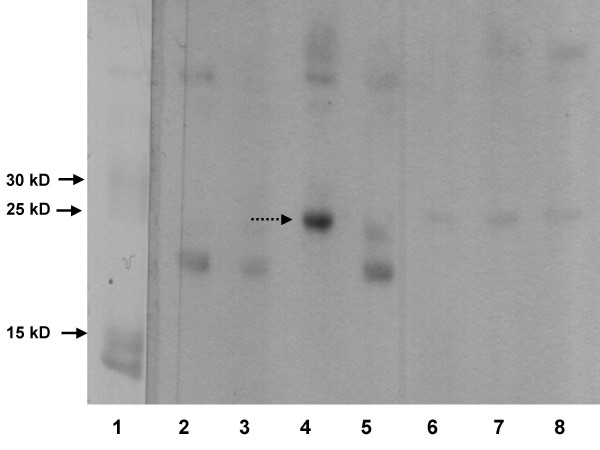
Western blot analysis for PIF after urinary protein extraction. Lane 1: Rainbow® recombinant protein molecular weight marker (#RPN 800, Amersham Life Science); lane 2: healthy control person, lanes 3 and 5: chronic pancreatitis, PIF not detected, lanes 4 and 7: pancreatic cancer, UICC stage 1 and 2, respectively, PIF detected (24 kD, broken line); lanes 6: chronic pancreatitis, PIF detected; lane 8: positive control (pancreatic cancer, UICC stage 4)